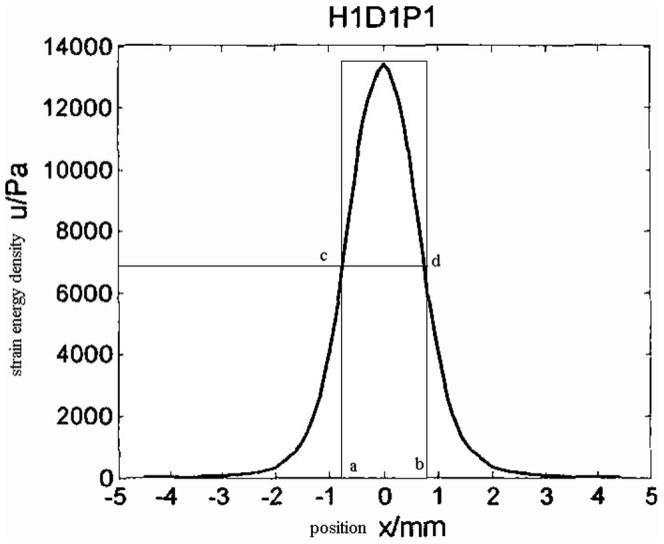
Strain energy density relative to position.